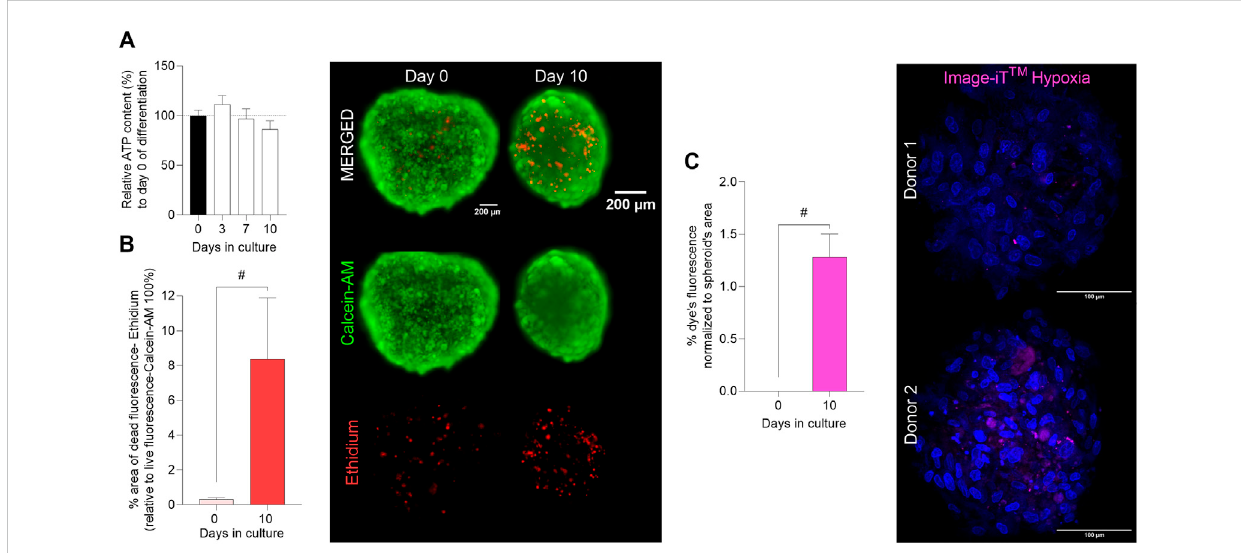
FIGURE 2 Evaluation of cell viability and hypoxia core in 3D muscle spheroids. Myospheres were formed in the ultra-low attachment treatment (ULA) 96-well platesystemanddifferentiationwascarriedoutbetween0and10days. (A)